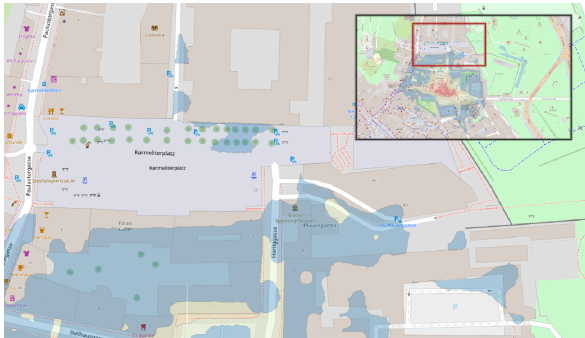
Figure 6. Location of the explosive charge in the center of the city. Figure 8. Comparison of damage zones overlayed on a street map for charge sizes of 10 kg (top) and 100 kg (bottom). pressure effects caused by buildings.